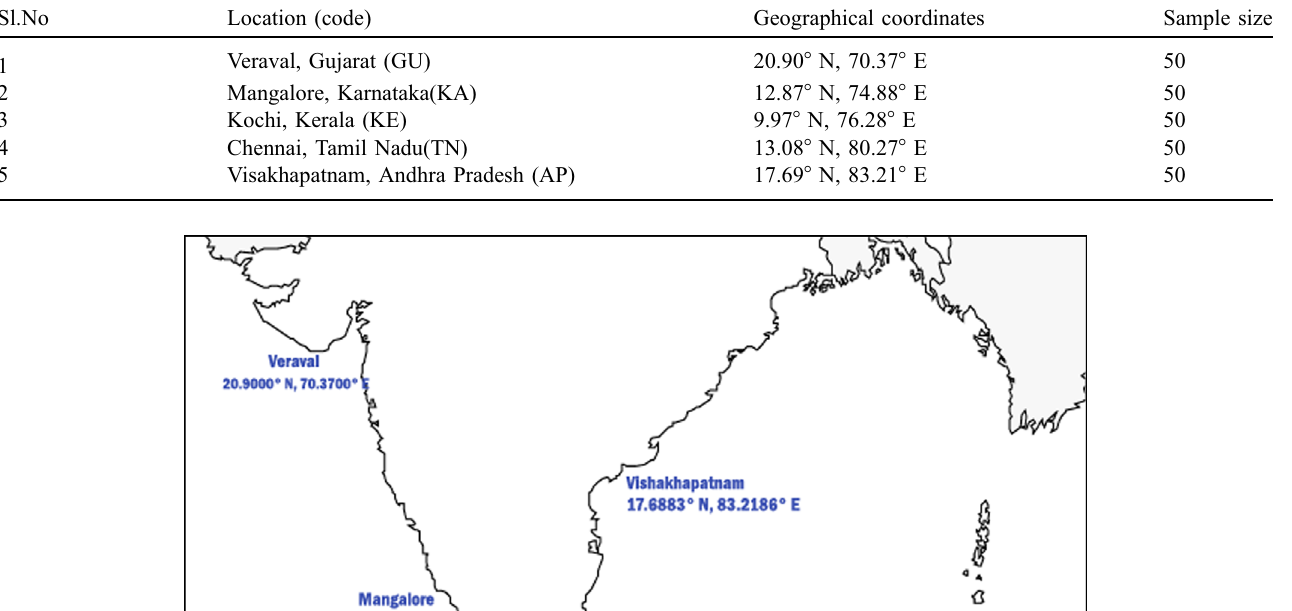
Table 1. Collection locations of S. commerson in the Arabian Sea and Bay of Bengal.